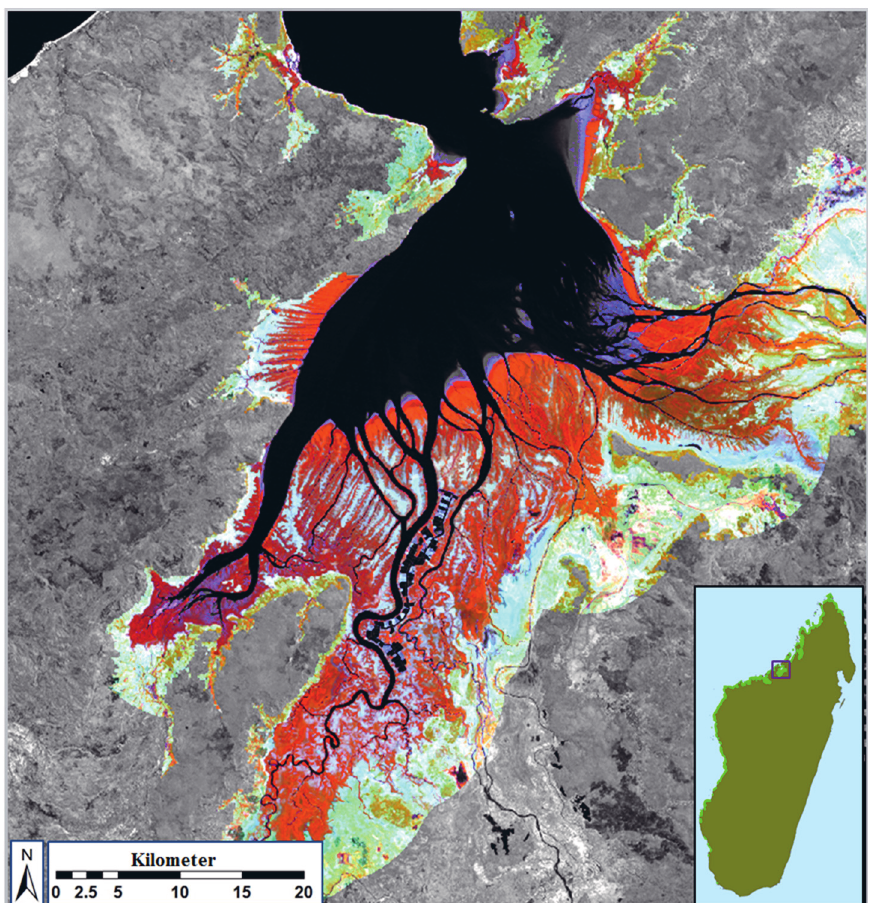
Figure 1. The AOI extent is shown using a masked false color composite of Landsat 5 Thematic Mapper (TM) bands 3, 5, and 4, wherein mangrove vegetation appears primarily in vibrant shades of red and orange. The background image is Landsat 5 TM band 4. The location within Madagascar and the national distribution of mangroves (bright green) are shown in the country-wide inset (bottom right: data obtained from Giri